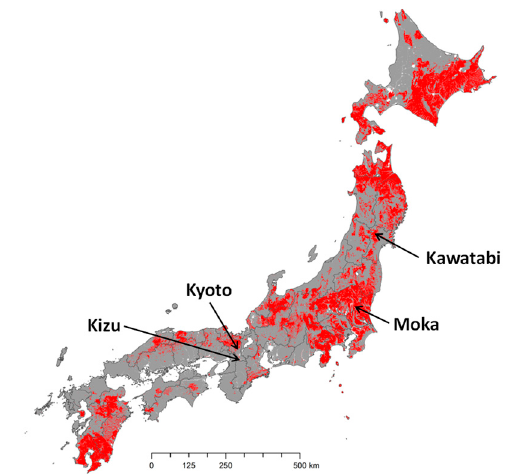
Figure 1. Map of the Japan mainland showing the distribution of Andosols (red) and the locations of the sampled farms. The distribution of Andosols is based on map data in the Digital Soil Map of Japan [16], available at the website of the National Agriculture and Food Research Organization (NARO).